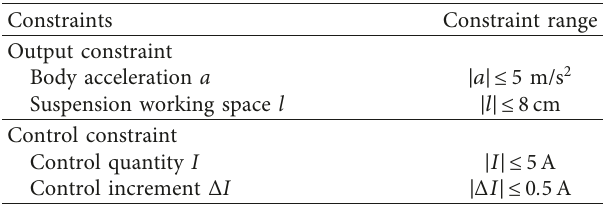
Figure 9: Structure diagram of the predictive control system. Table 5: Rolling optimization constraints.